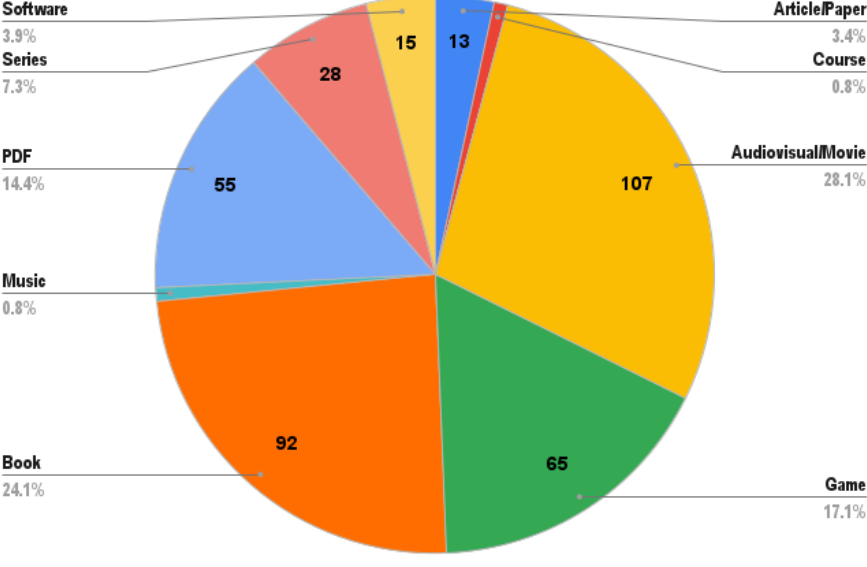
Figure 11. Material or content